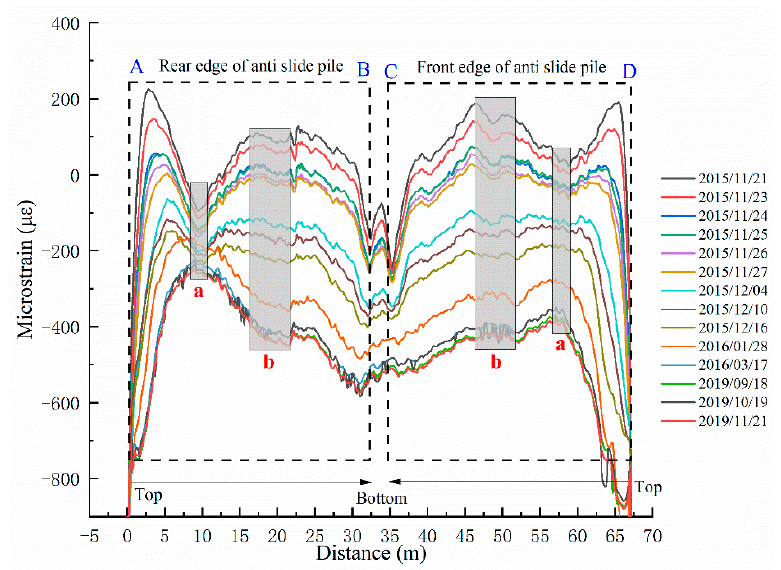
Figure 6. Temperature curves of MS-T1 for different periods. (In this figure, a and b represent the same meanings as in Figure 5).